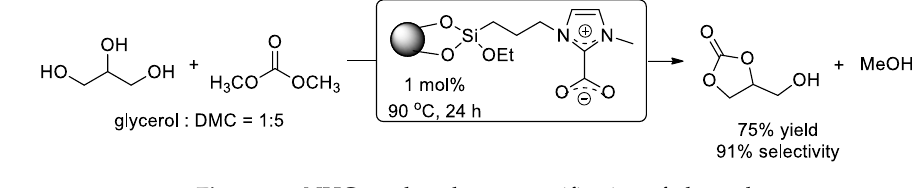
Figure 12. NHC-catalyzed transesterification of glycerol.